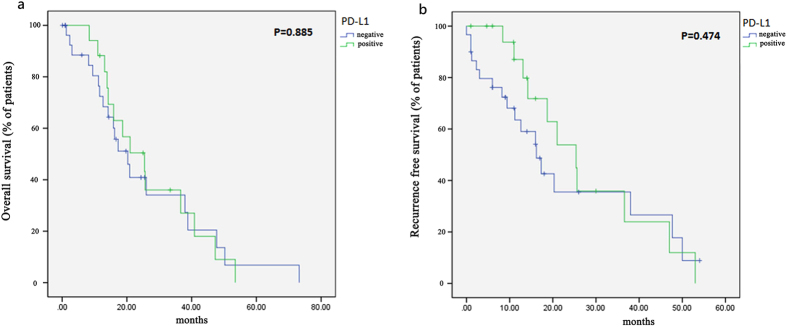
Kaplan–Meier survival curves.(a) The was no significant difference regarding overall survival between PD-L1 positive and negative group. (b) The was no significant difference regarding recurrence free survival between PD-L1 positive and negative group.